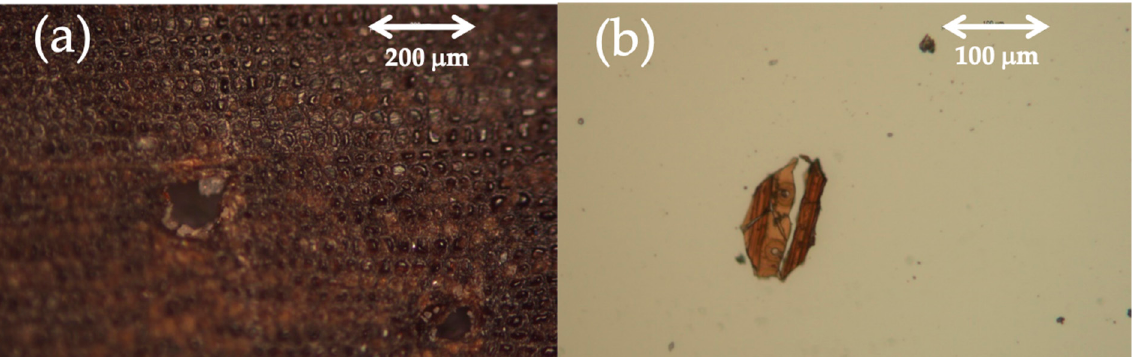
Figure 7. Microphotographs of the wood support (sample D-1): ( a ) cross-section; ( b ) tracheid pitting in radial section.